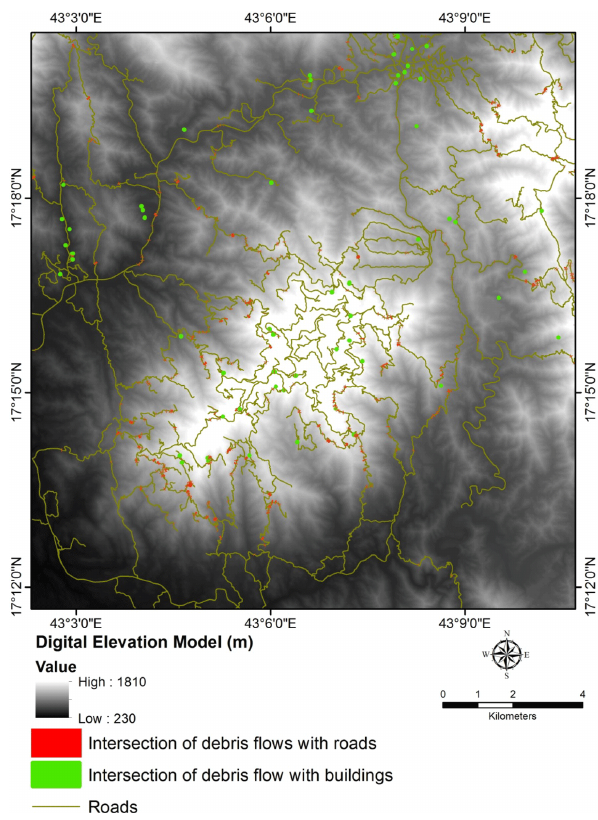
Figure 7. Map showing intersections of debris flows with roads and